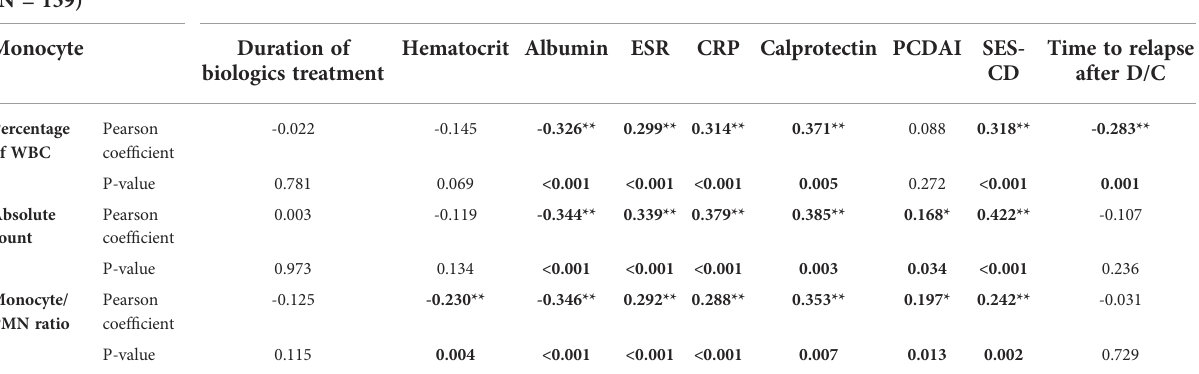
TABLE 3 Correlation analysis between monocyte and variables at the time of biologic discontinuation using Pearson correlation analysis. Crohn ’ s